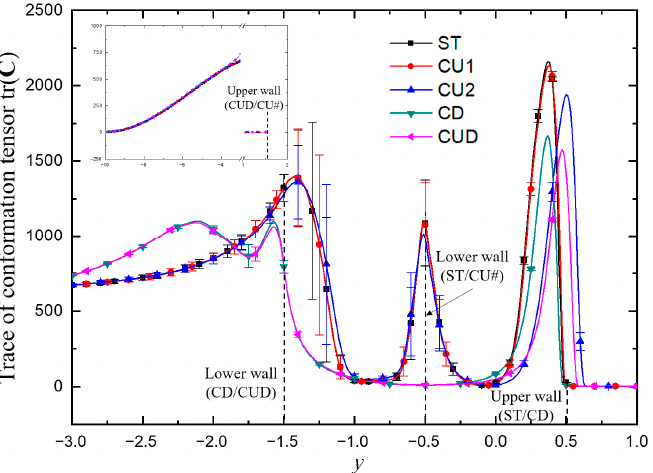
Figure 13. The time-averaged trace of conformation tensor tr( C ) changes along the line of x = − 0.4 showing the local near-wall information about molecular structure stretching in the throat region of the T-shaped channels. The error bar is the standard deviation of tr( C ). Inset: the range of y covers from y = − 10 (the inlet) to y = − 3 and from y = 1 to y = 1.5, where no peaks or valleys of tr( C ) profiles appear. For all cases, β = 0.5, Wi = 5.